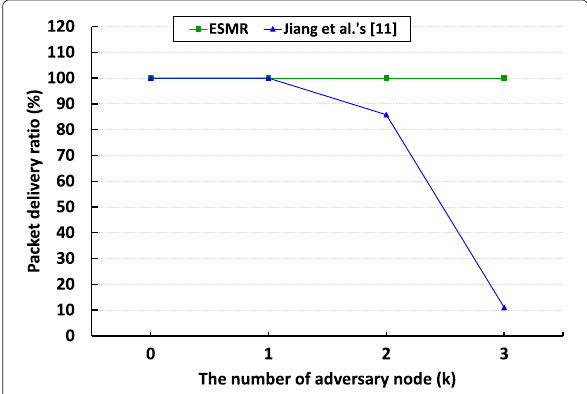
cluster head except for the foreign cluster head. Hop dis- tance between the mobile node and home cluster head was set to 1, and message transmission interval of adver- sary nodes was set to 10 ms. Three cases were considered for the simulation where the number of adversary nodes ( k ) varies from one to three. Simulations were conducted 500 times per case for Jiang et al.’s scheme [11] and ESMR.